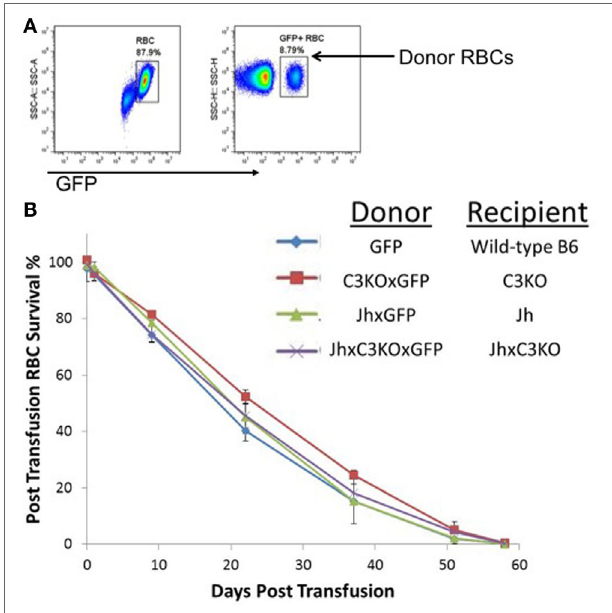
FigUre 1 | Red blood cell (RBC) clearance is normal in mice deficient in either immunoglobulin, C3, or both. RBCs from GFP + mice of the indicated strains were transfused into GFP − mice of the same strains. (a) Transfused RBCs were visualized by flow cytometry after gating on the RBC population by forward and size scatter (representative panels shown). (B) Percentage of circulating RBCs was determined at each of the indicated time points, longitudinally in the same mice for the length of the experiment. To allow monitoring of RBCs for the entire RBC lifespan, 100 μ L of GFP + RBCs were transfused, resulting in an approximate 10% of RBCs at the beginning of the experiment [representative flow cytometry shown in panel (a) ]. There were three mice included in each group; error bars represent SD. A representative experiment is shown; similar results were observed in three out of three